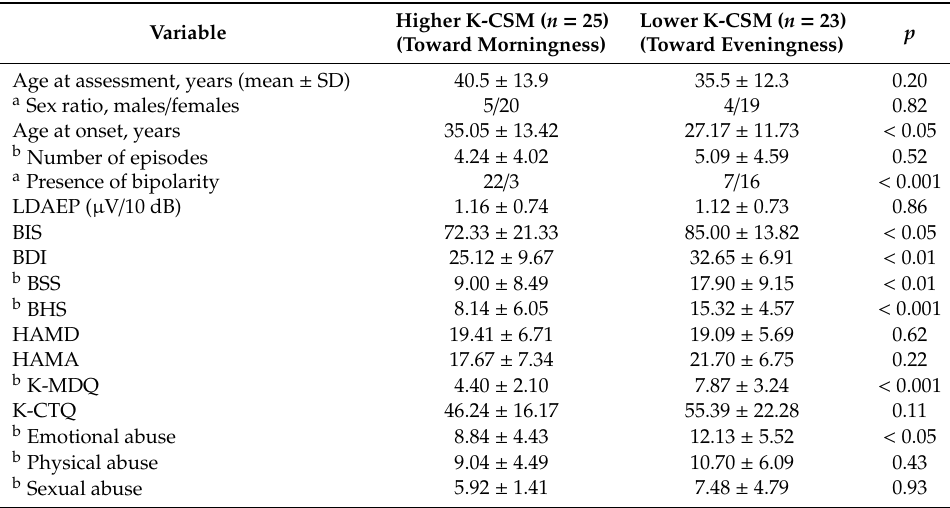
Table 2. Comparison of demographic and clinical variables between the two groups dichotomized according to the median K-CSM score.